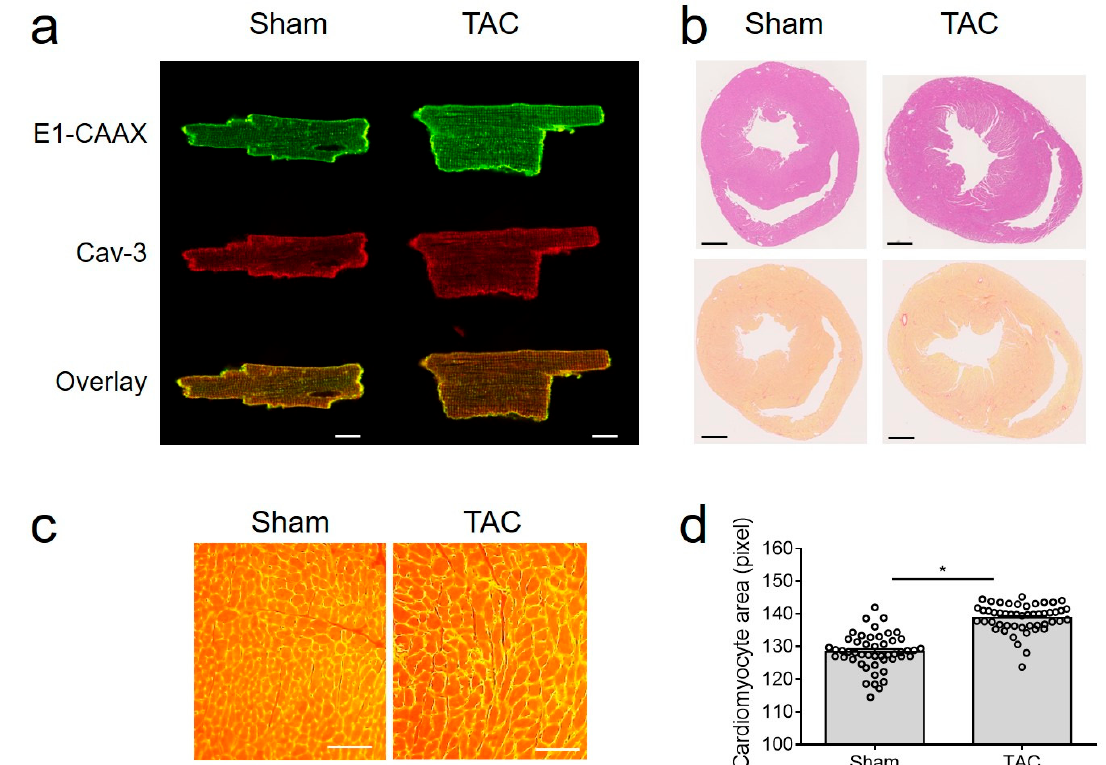
Figure 2. TAC model in E1-CAAX mice. ( a ) Confocal images of sham and TAC AMVMs taken as described in Figure 1b. Scale bar, 10 µm. ( b ) Hematoxylin/eosin and picrosirius red stainings of cross-sections from sham and TAC hearts of E1-CAAX mice. Scale bars, 1 mm. ( c ) WGA staining of sham and TAC heart tissues. Scale bars, 50 µm. ( d ) Quantification of AMVM area. * p < 0.05 by one-way ANOVA.